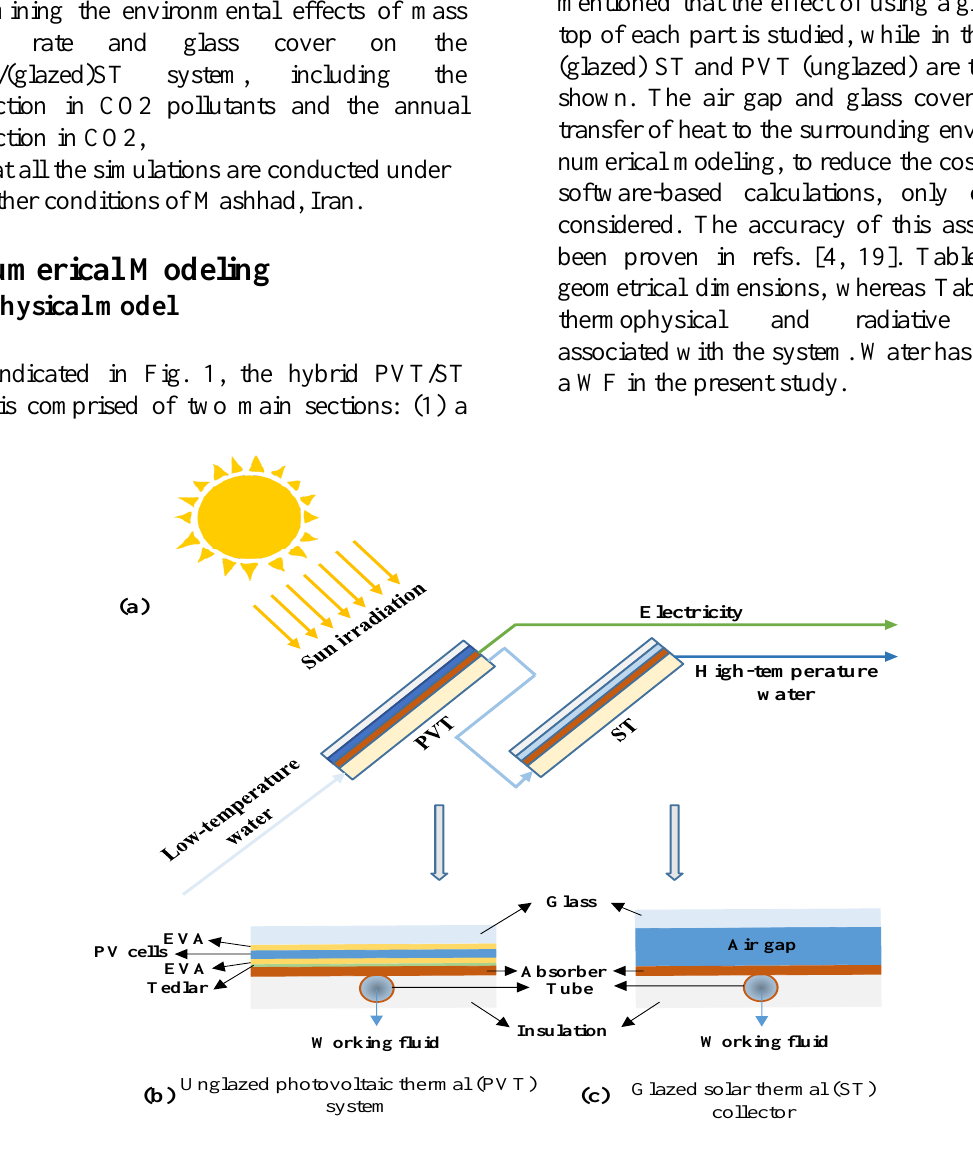
Fig. 1 (a) Schematics of the PVT/ST system along with cross-sectional views of (b) unglazed photovoltaic thermal (PVT) system and (c) glazed solar thermal (ST) collector with their various